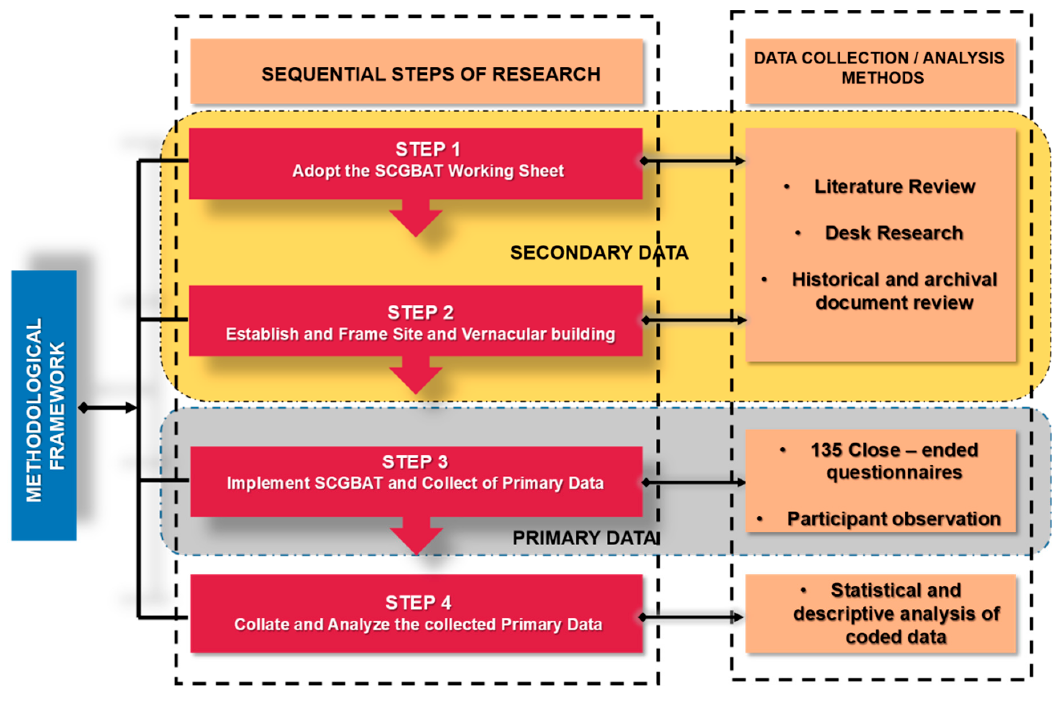
Figure 1. The methodological framework for research.